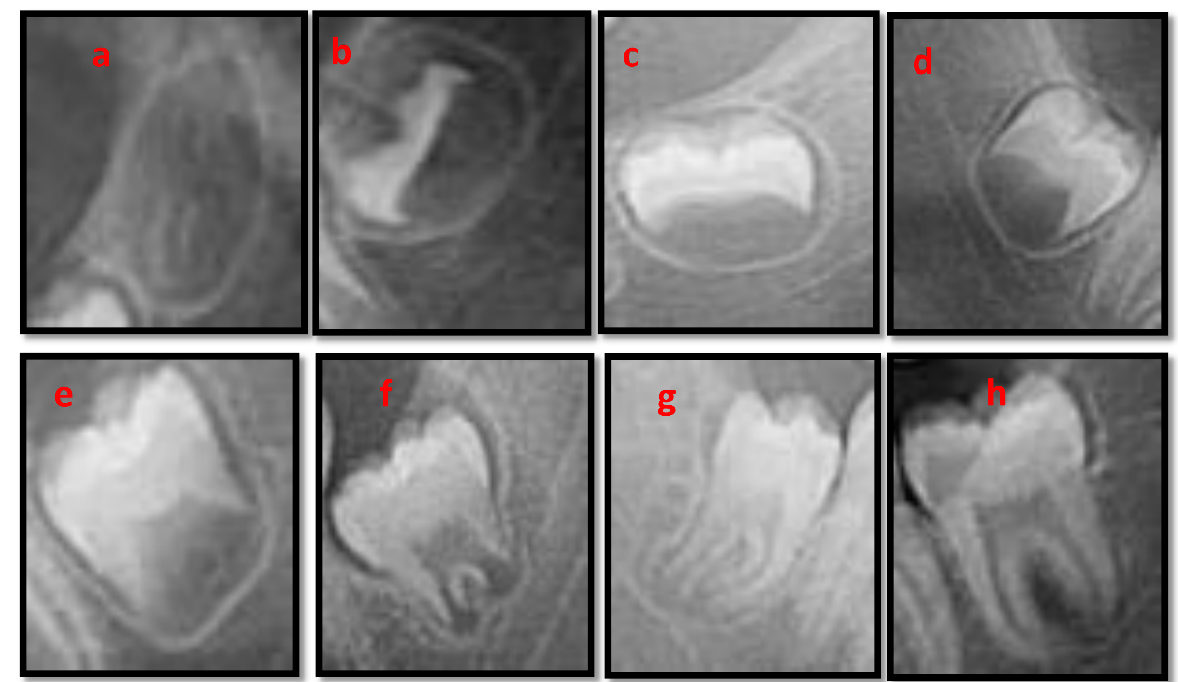
Figure 1: Third molars' mineralization stages.